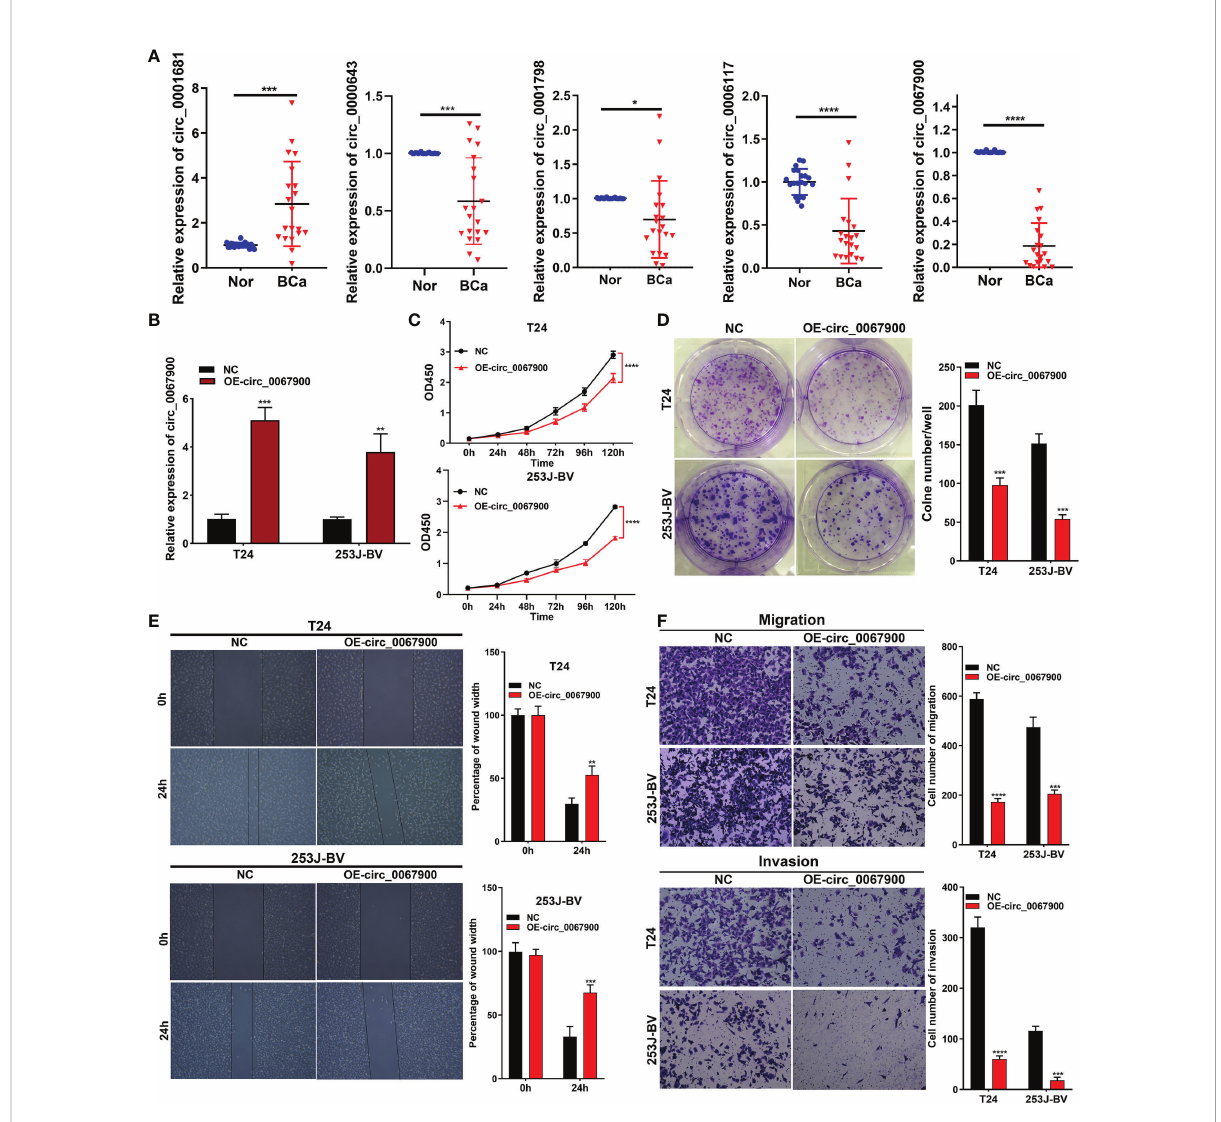
FIGURE 10 circ_0067900 overexpression exerted a tumor suppressive effect in BCa cells. (A) Five circRNAs were randomly chosen to verify the circRNA- sequencing results in 20 pairs of samples by quantitative real-time PCR. (B) Lentiviral transduction ef fi ciencies were evaluated using RT-qPCR in T24 and 253J-BV cells. (C) CCK-8 proliferation assay. (D) OE-circ_0067900 inhibited monoclonal formation ability of BCa cells. (E) Scratch assay of T24 and 253J-BV cells. Experiments were terminated after scratch for 24 h. (F) Migration and invasion were evaluated using a transwell assay without and with Matrigel, respectively. Data are showed as means ± SD; n = 3. SD, standard deviation; OE-, Overexpression; NC, negative control vector; CCK-8, cell counting kit-8; OD, optical density. *P < 0.05, **P < 0.01, ***P < 0.001 and ****P <